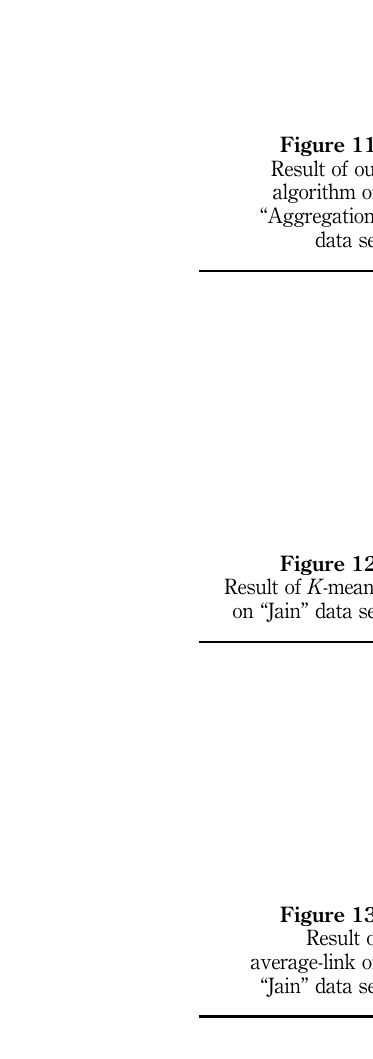
Figure 11. Result of our algorithm on “ Aggregation ” data set